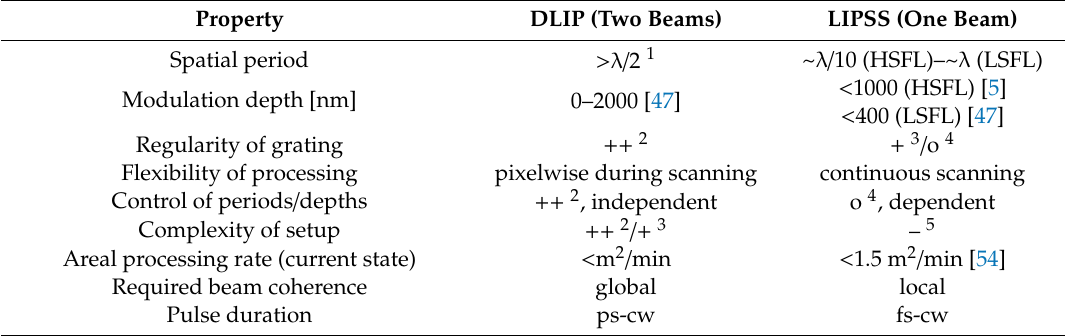
Table 5. Comparison of single beam surface processing of LIPSS with two-beam based DLIP structures. Property DLIP (Two Beams) LIPSS (One Beam) Spatial period > λ / 2 1 Modulation depth [nm] 0–2000 [47] Regularity of grating Flexibility of processing pixelwise during scanning continuous scanning Control of periods /